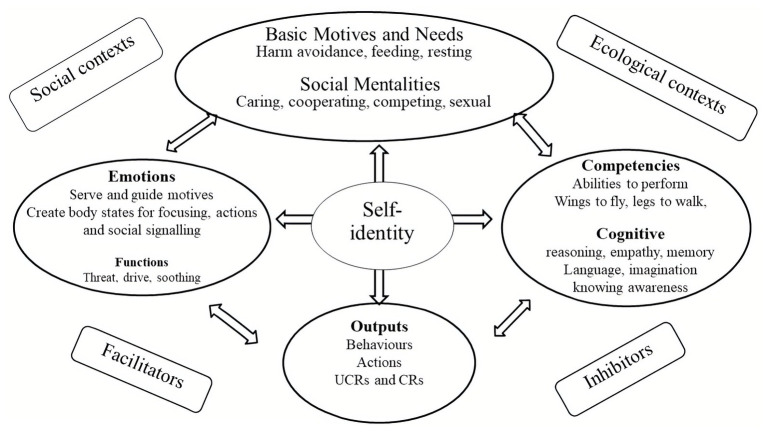
Mapping the mind. Adapted from Gilbert (2019).